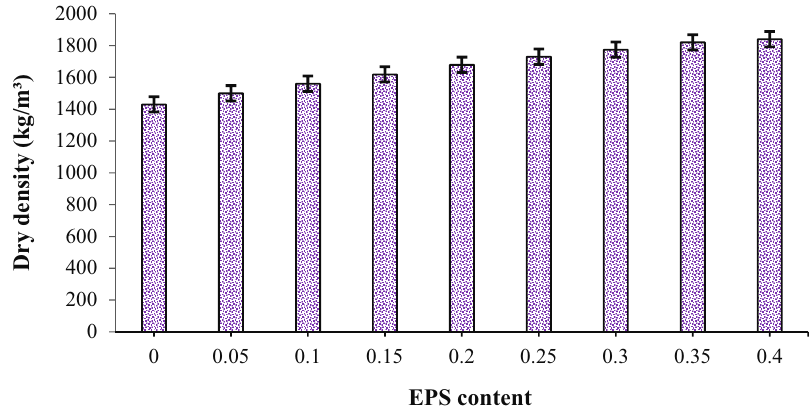
Figure 4: E ff ect of EPS on the dry density of varied AC